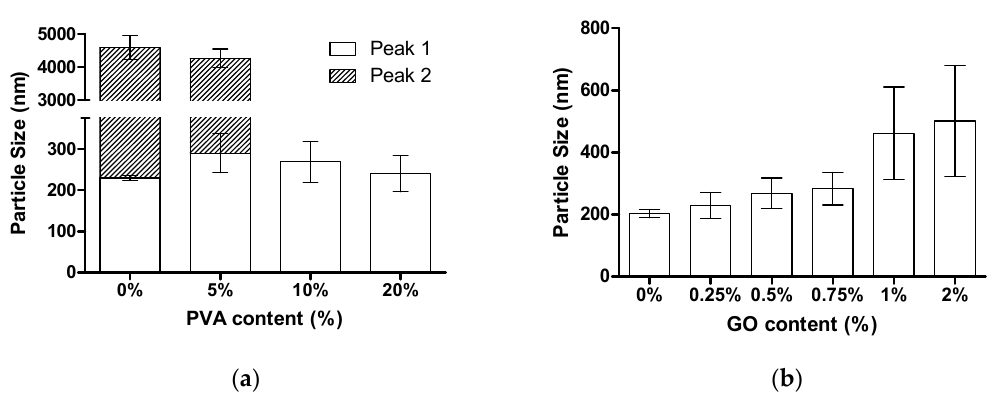
Figure 7. Effect of ( a ) the PVA loading (0.5% of GO), and ( b ) the GO loading (10% PVA) on the particle Figure 7. E ff ect of ( a ) the PVA loading (0.5% of GO), and ( b ) the GO loading (10% PVA) sizes and size distribution of nanocomposite PMMA/GO latex prepared via miniemulsion on the particle sizes and size distribution of nanocomposite PMMA / GO latex prepared via polymerization. miniemulsion